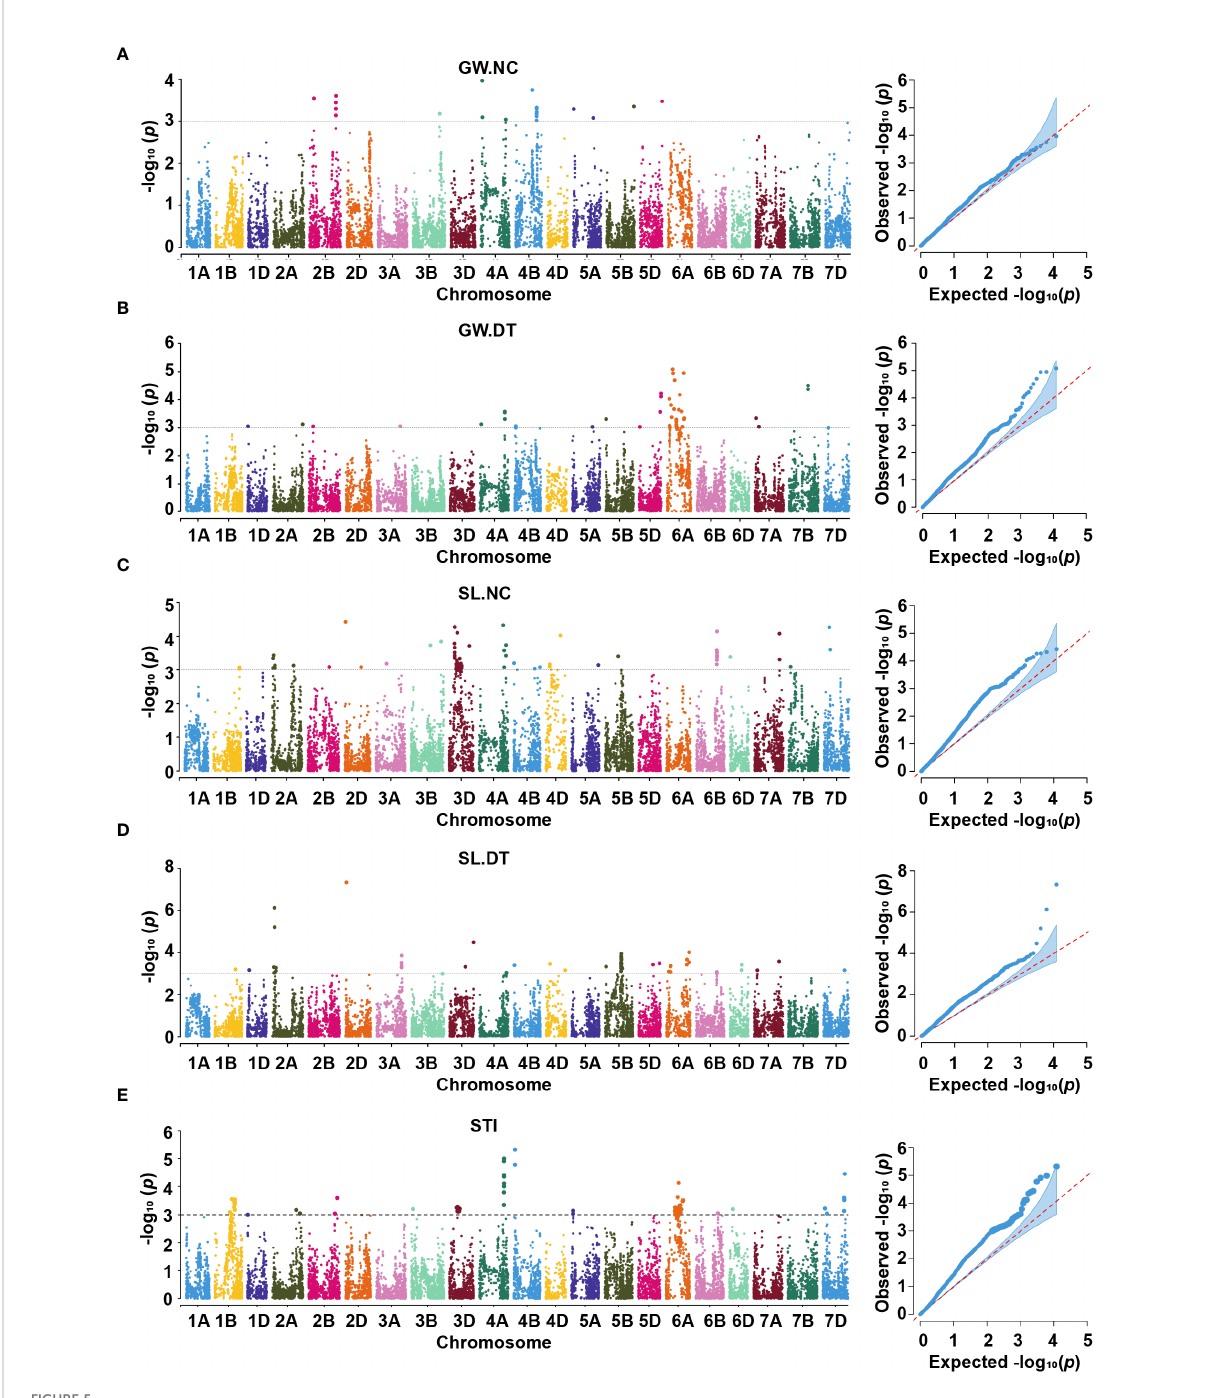
FIGURE 5 Manhattan and Q-Q plots for grain width (A, B) , spike length (C, D) and stress tolerance index (E) under two conditions. GW.NC, grain width under normal conditions; GW.DT, grain width under drought treatment conditions; SL.NC, spike length under normal conditions; SL.DT, spike length under drought treatment conditions; STI, stress tolerance